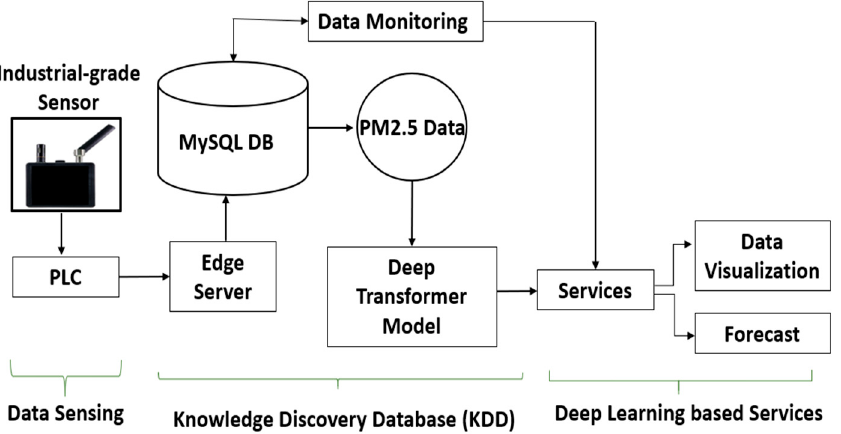
Figure 1. The hardware architecture with three phases of the proposed data acquisition system: data sensing, KDD, and deep learning-based services.